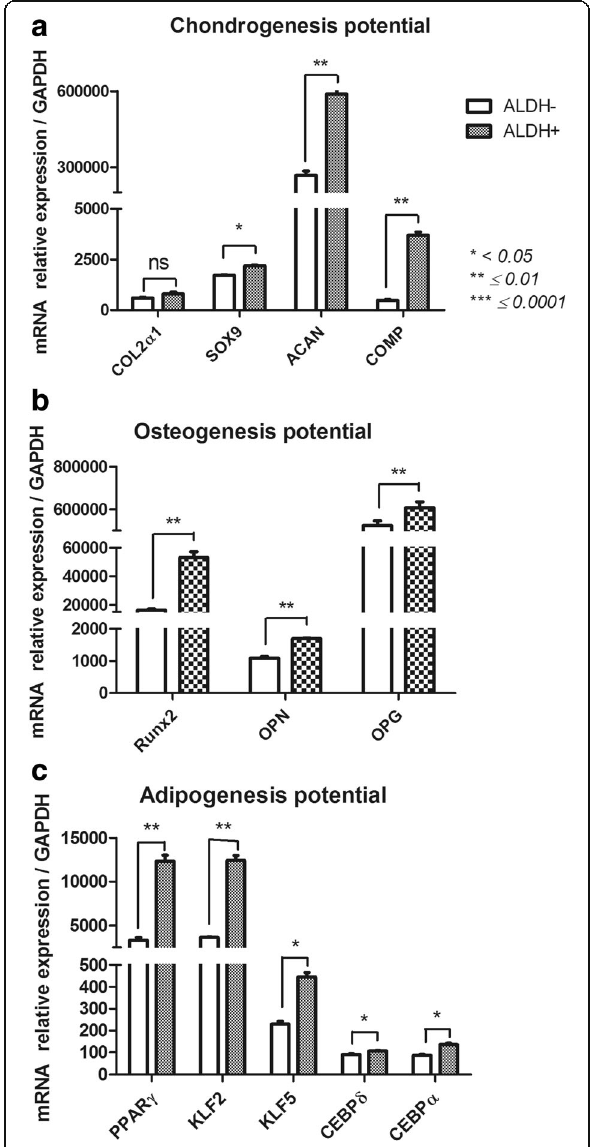
Fig. 10 Multilineage-related gene expression profile of FSK-MSC subsets according to ALDH activity. After flow cytometry sorting of ALDH+ and ALDH- FSK-MSC subsets, we investigated by qPCR the expression profiles of multilineage-associated genes such as COL2a1, SOX9, CAN, COMP for chondrogenesis ( a ), Runx2, OPN, OPG for osteogenesis ( b ) and PPAR γ , KLF2, KLF5, CEBP α , CEBP δ for adipogenesis ( c ). Data are presented as mean±SEM of mRNA gene expression relative to GAPDH expression. (ns=non